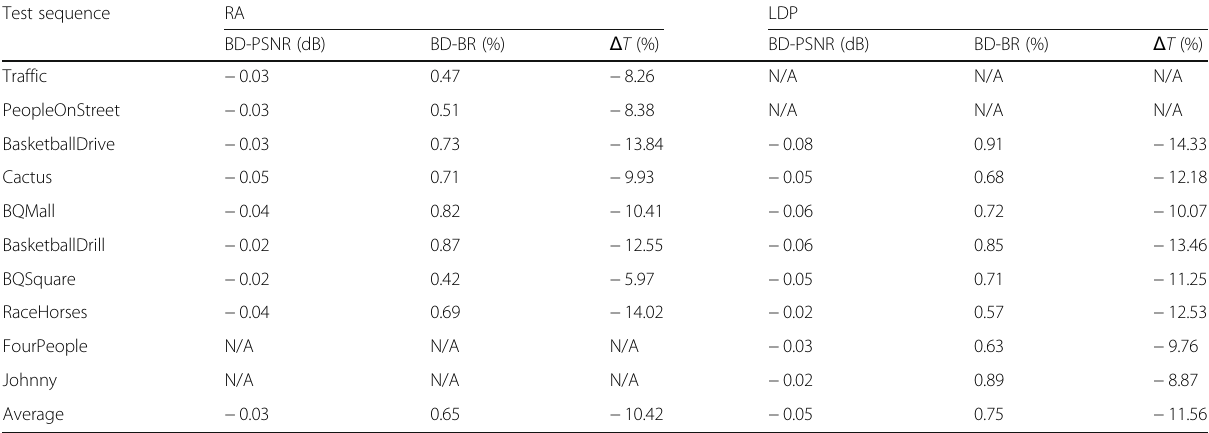
Table 8 Comparison between ADS and the original HM 14.0 Test